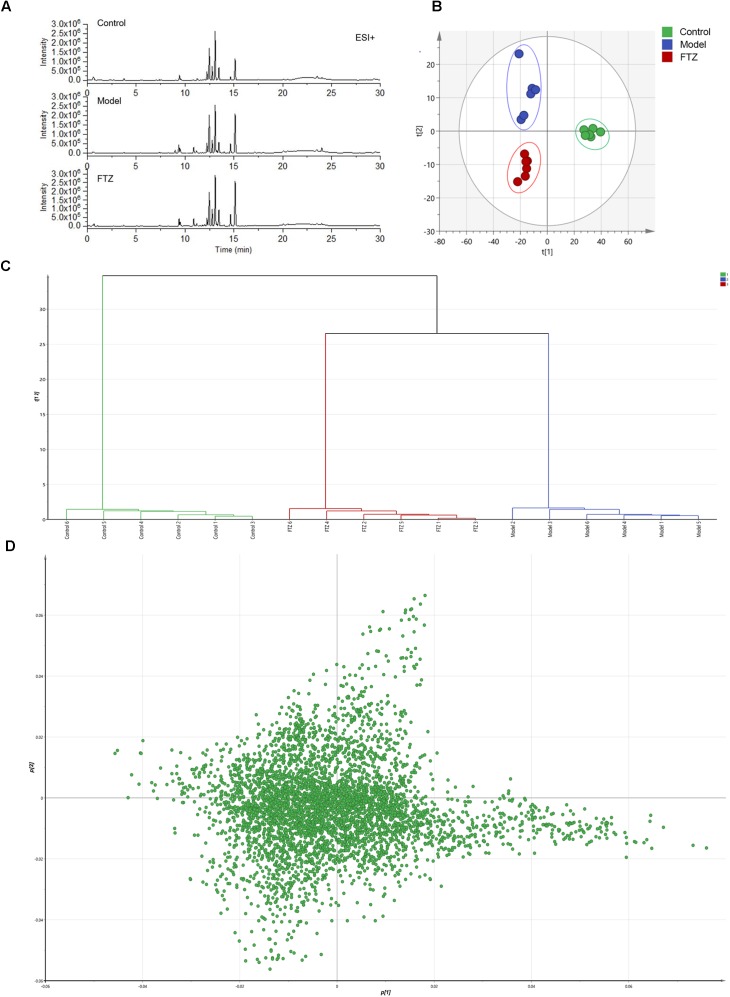
Metabolic profiling and multivariate statistical analysis. (A) Base peak intensity chromatograms of control, model, and FTZ groups in positive ion mode obtained from UPLC-QTOF/MS analysis. (B) Score plot of PLS-DA of control, model, and FTZ groups. [R2X(cum) = 0.971, Q2(cum) = 0.738]. (C) Clustering analysis of control, model, and FTZ groups. (D) Loading plot of PLS-DA in positive ion mode from control, model, and FTZ groups.